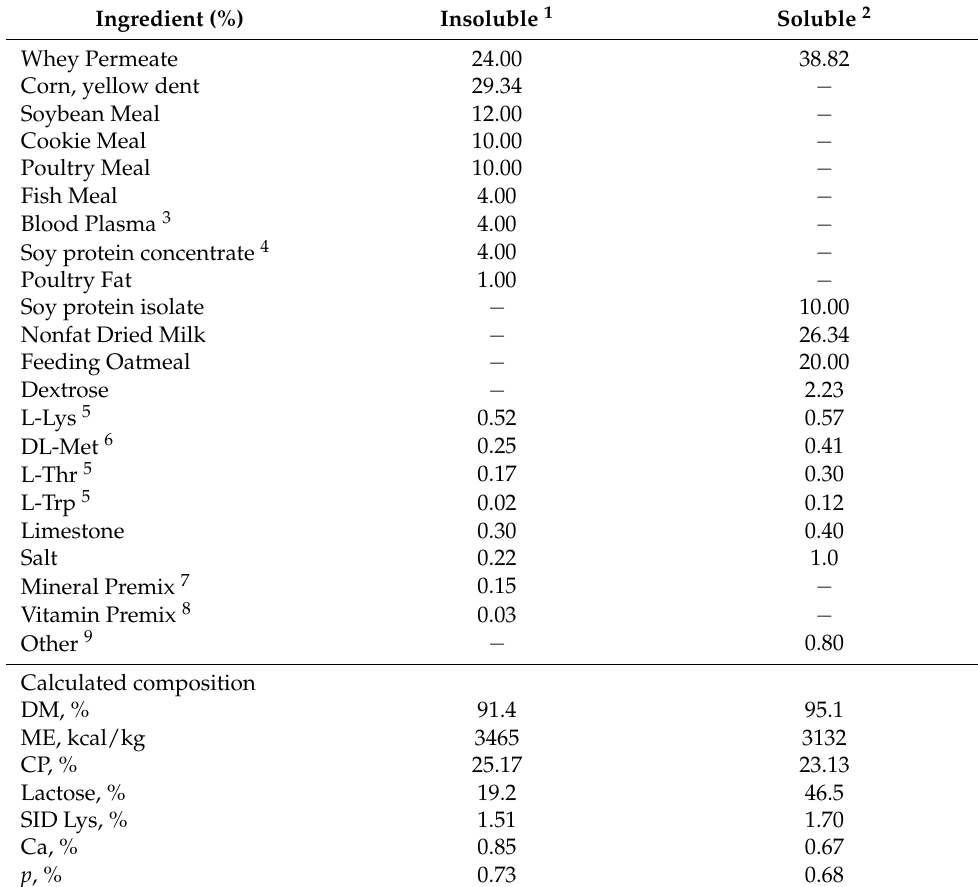
Table 1. Divergent diets given to suckling pigs using gruel creep